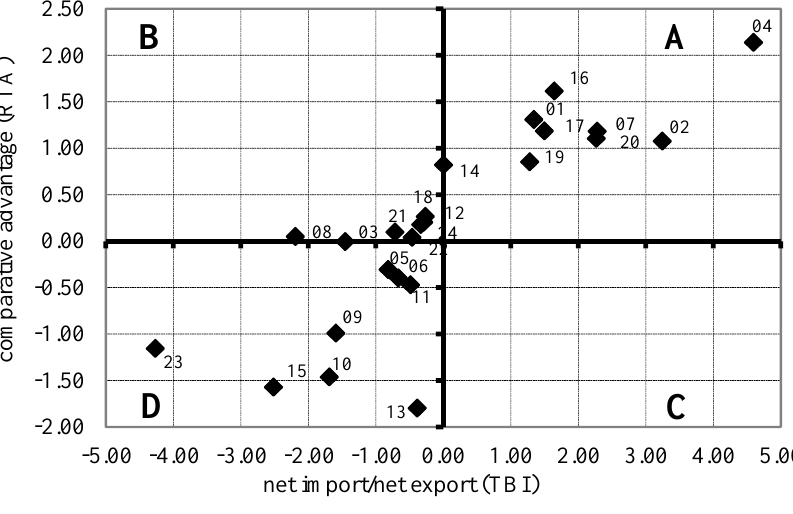
Figure 3. Positioning of agri-food products by the level of comparative advantages and export-import relations in 2004, by HS chapters